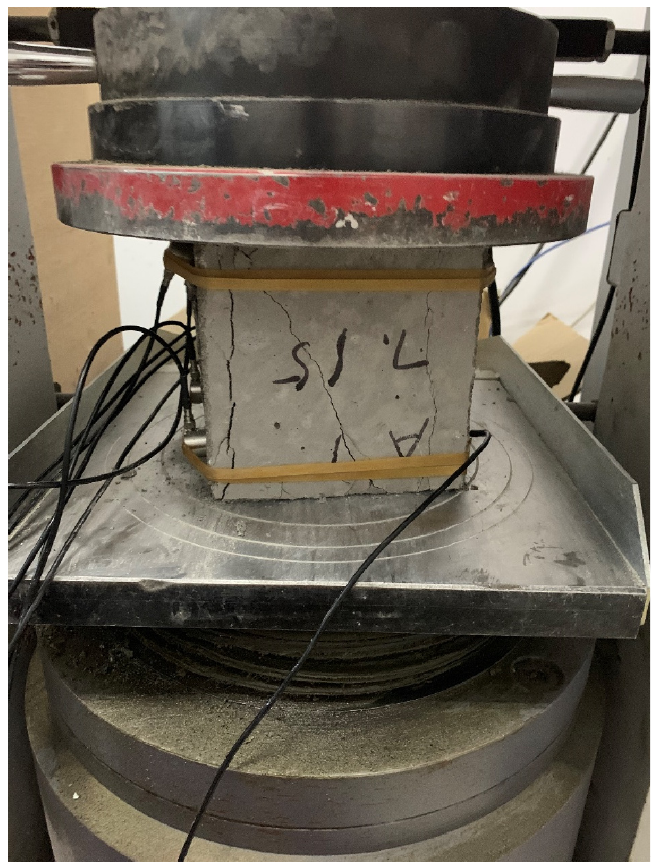
Figure 5. The layout of measuring points. ( a ) two-dimensional; ( b ) three-dimensional